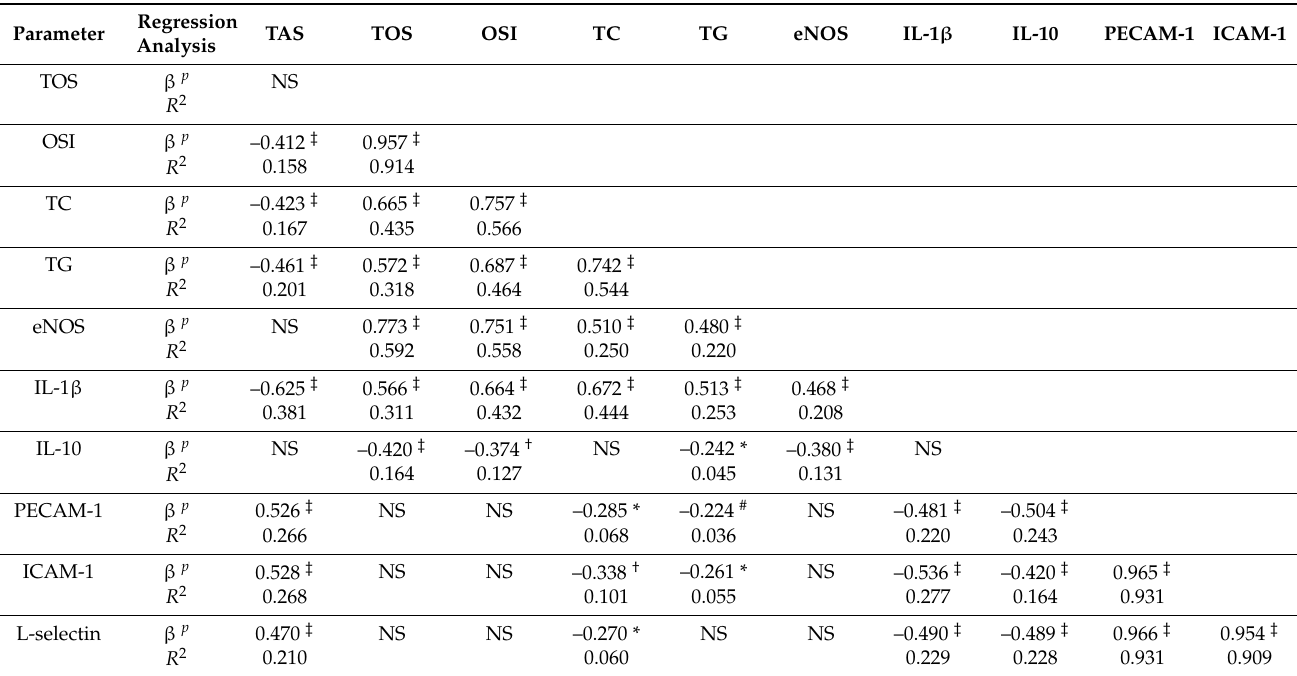
Table 8. Mutual relationships between the investigated parameters in the vascular tissue of the abdominal aorta 3